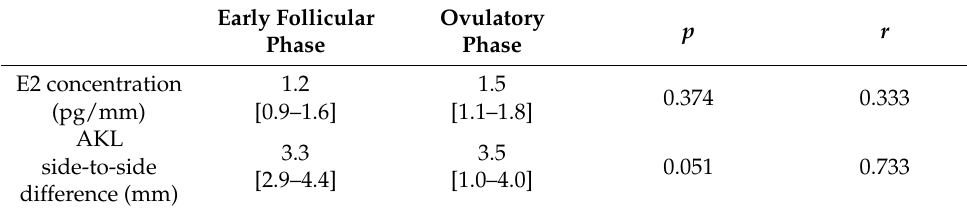
Table 2. E2 concentration, AKL side-to-side difference.